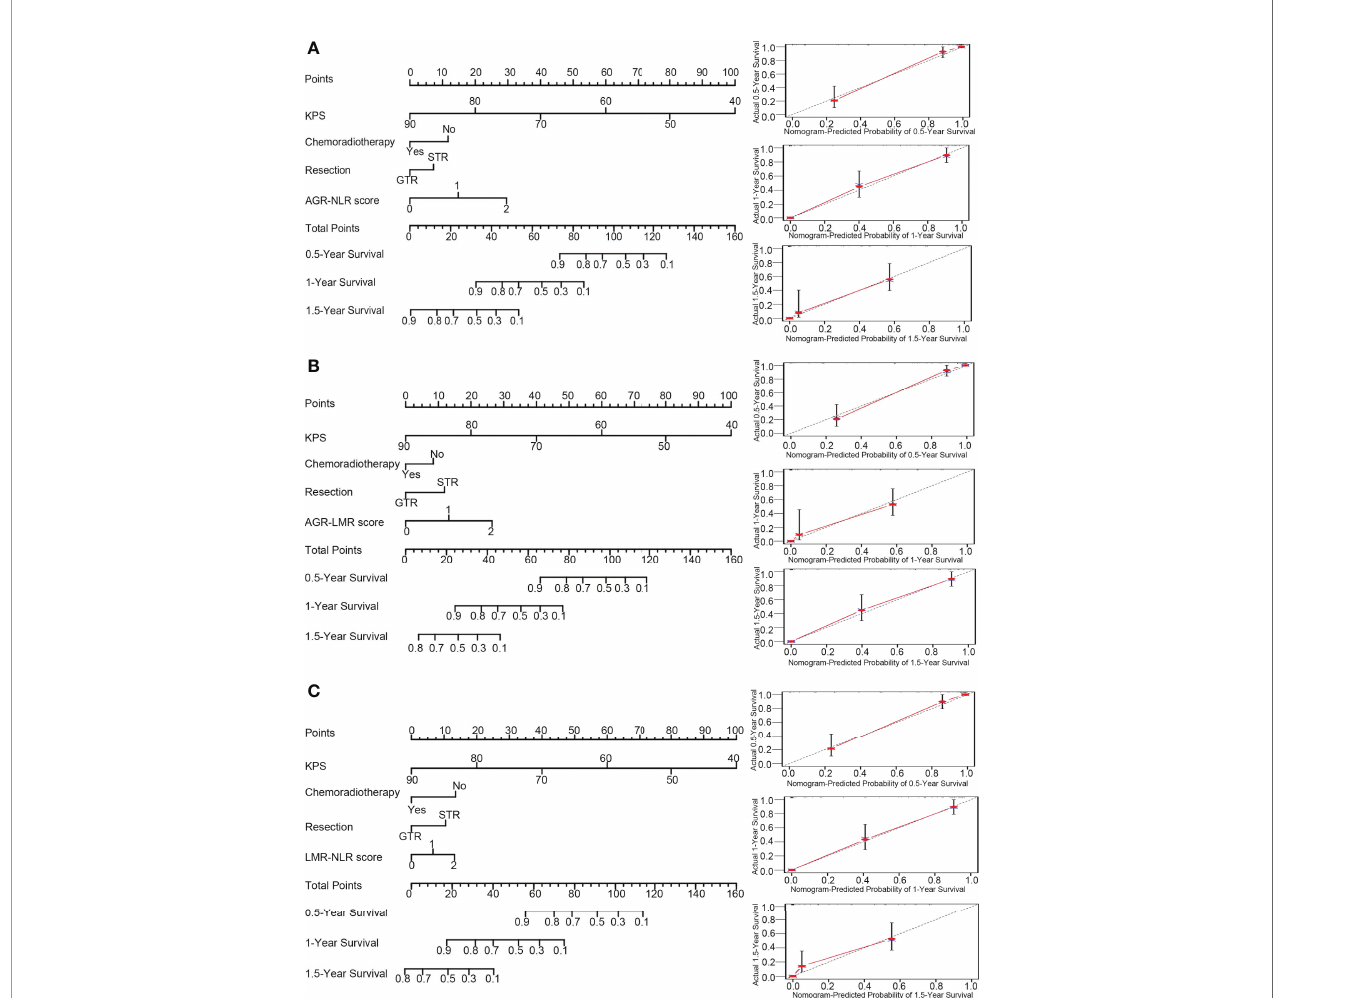
FIGURE 3 | Nomograms and calibration curve. In the nomograms (left panel), each variable was assigned different points that are indicated at the top scale, and the total points of all variables generated a numerical prediction of the 0.5-, 1.0- and 1.5-year survival rates, where a higher score indicates a worse outcome. In the calibration curve (right panel), the dotted line indicates the ideal prediction and the full red line indicates the performance of the nomogram. (A) Nomogram and calibration curve concerning AGN-NLR score; (B) Nomogram and calibration curve concerning AGR-LMR score; (C) Nomogram and calibration curve concerning LMR-NLR